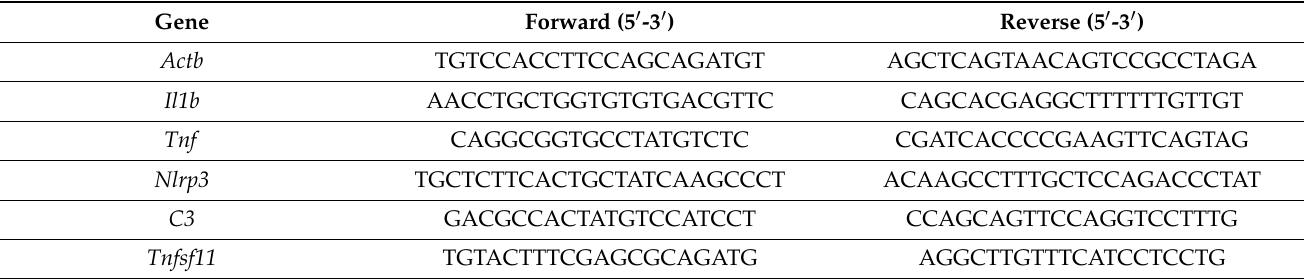
Table 1. Primers used for the